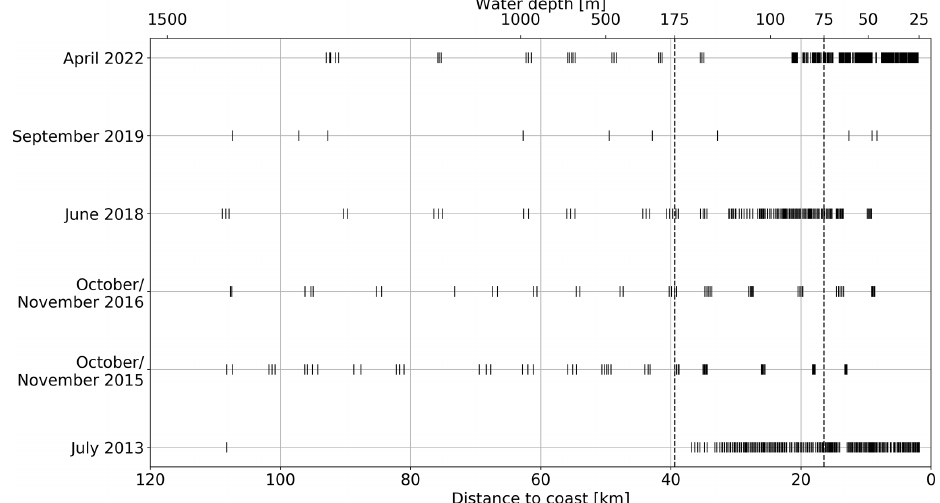
Figure 3. Distribution of microstructure profiles at the 11 ◦ S section as a function of distance to the coast, cruise, and water depth. Each tick marks a microstructure profile. The vertical dotted lines mark the three areas analysed in Sect. 4.3: shallow water (water depth < 75m), shelf break area (water depth > 75 and < 175m), and deep water (water depth >